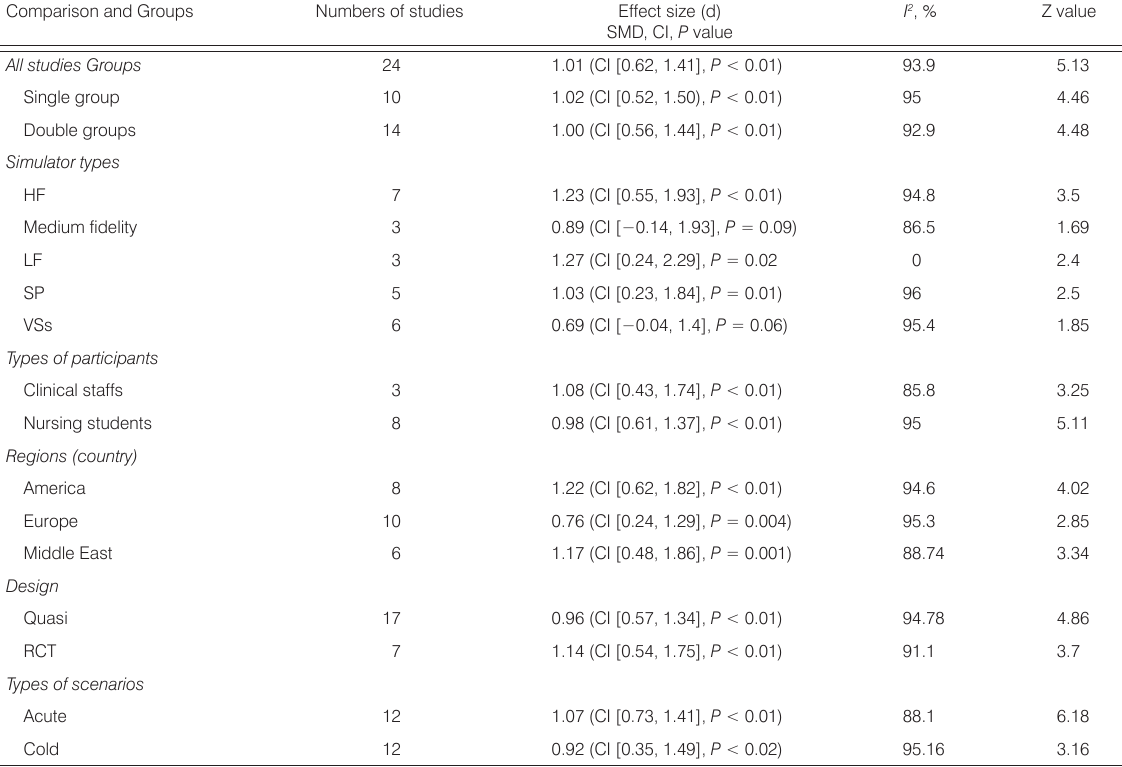
Table 2. Summary of effect size for subgroup